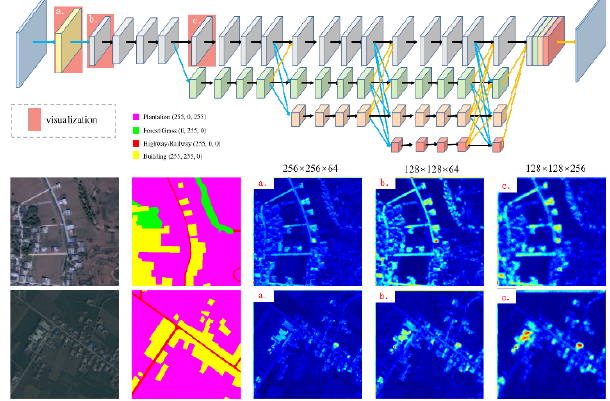
Figure 5. The visualizations of three selected feature maps ( a, b, c ) in HRNet with different two input images, one of which is the same as Fig. 2.